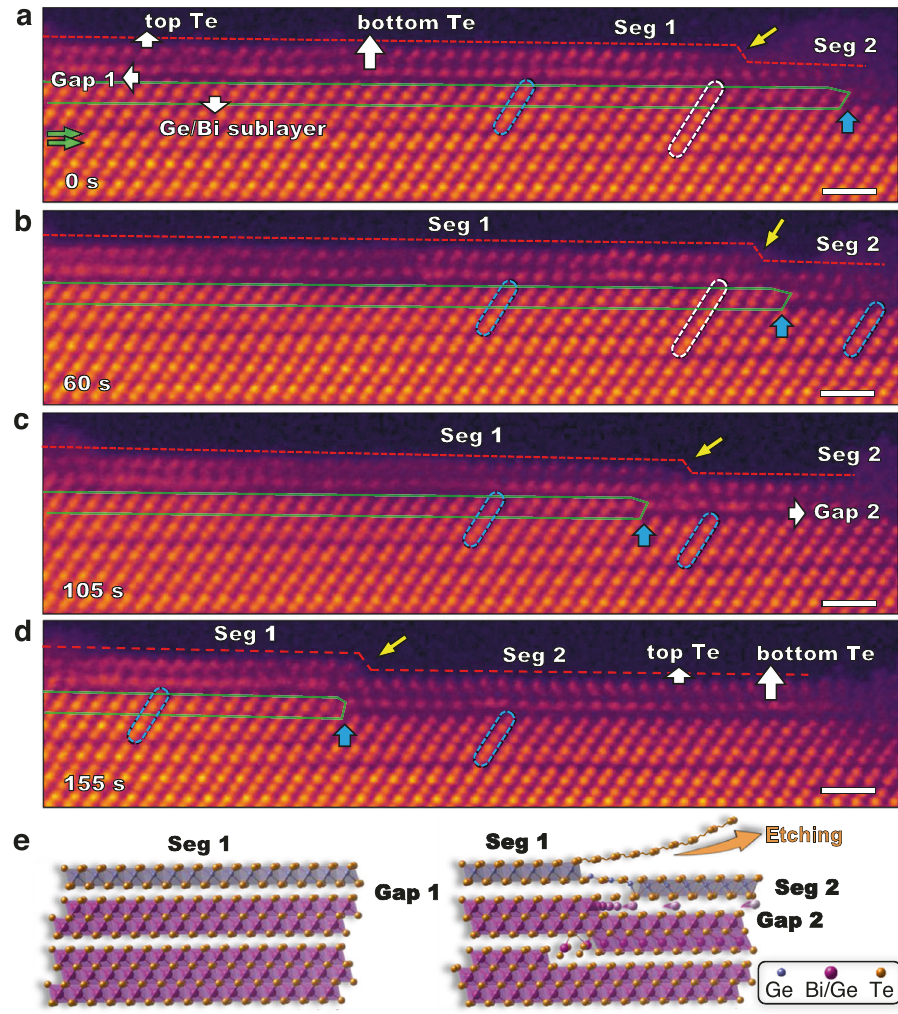
Fig. 4 | GeTe 2 TL (0001) surface reconstruction. In situ STEM images of the (0001)-terminated surface acquired at different time: a 0 s , b 60 s , c 105 s and d 155 s ,at400°C.ThereddashedlineonthesurfacetracestheoutlineofSeg1and Seg2,andthestepbetweenthemisindicatedbyyellowarrows.TheextraGe/Bihalf